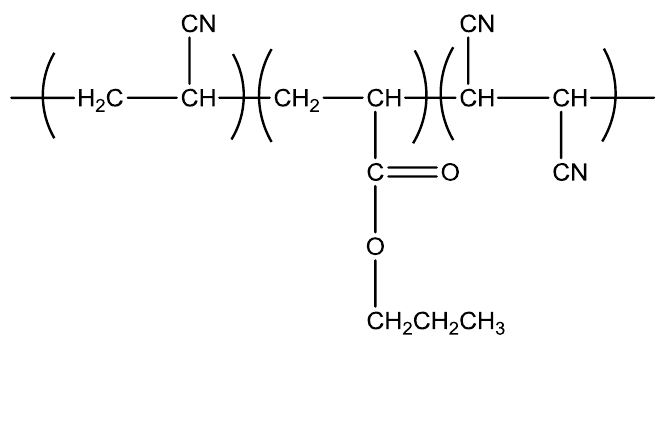
Figure 1. Poly(acrylonitrile/butyl